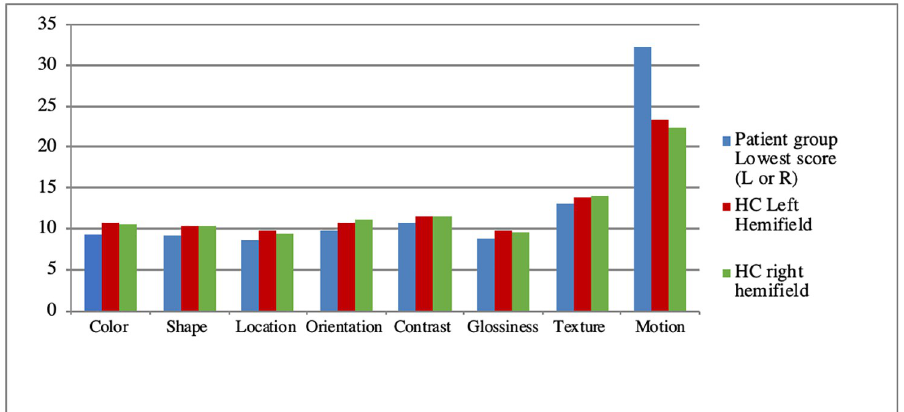
performance. Table 3 shows the percentages of patients with deficits per visual feature for the entire patient group. A score was treated as impaired when the threshold was in the lowest 5% of the HC group (M—1.64 � SD). As can be seen, the percentages of deficits ranged from approximately 13–14% (glossiness, shape and contrast) up to 26% (motion).